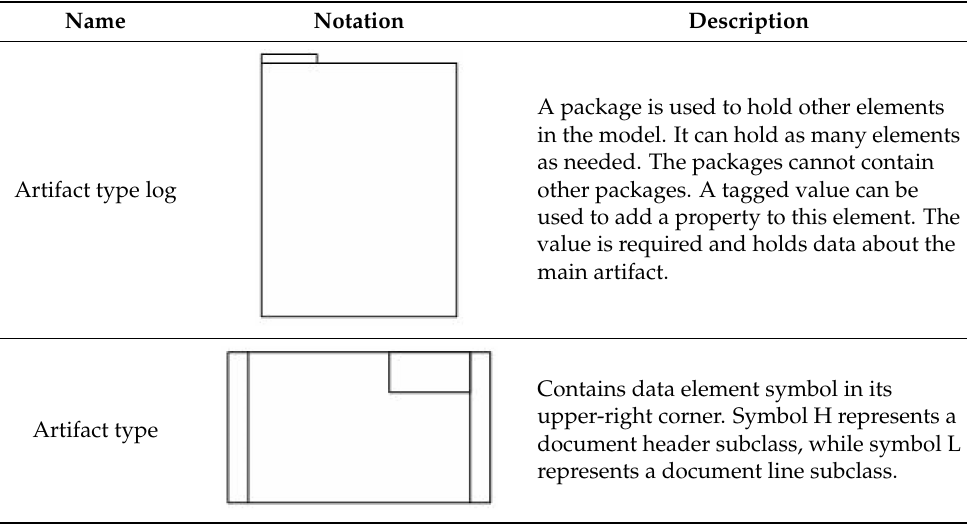
Table 1. Main elements of the domain-specific modeling